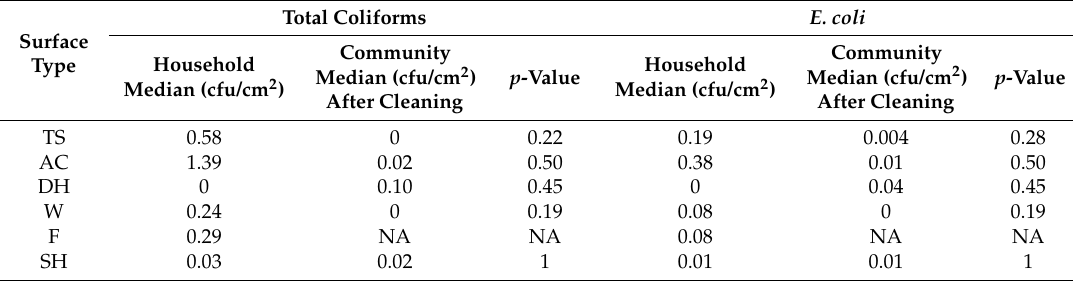
Table 5. Results of the Wilcoxon Signed Rank Test comparing the bacterial contamination of community latrine surfaces, during clean conditions, to the household latrine surfaces (bolded if significant). Surface